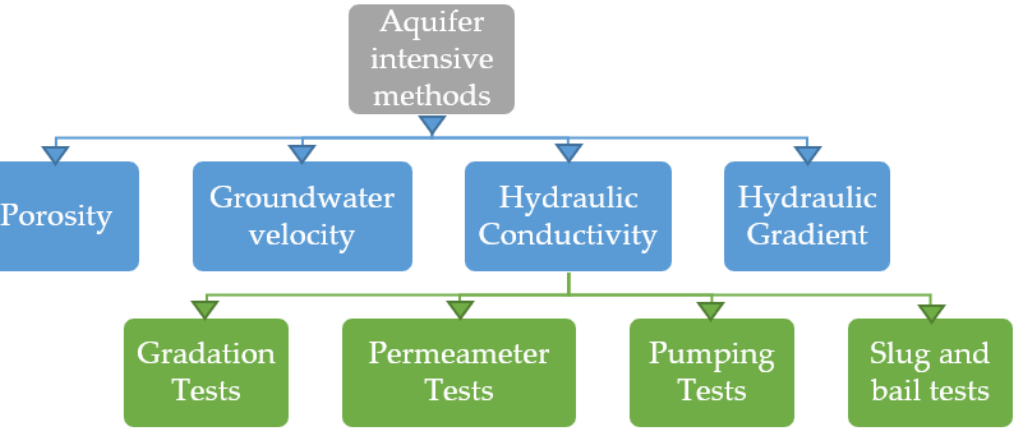
Figure 8. Aquifer intensive methods for quantifying GW–SW interactions.